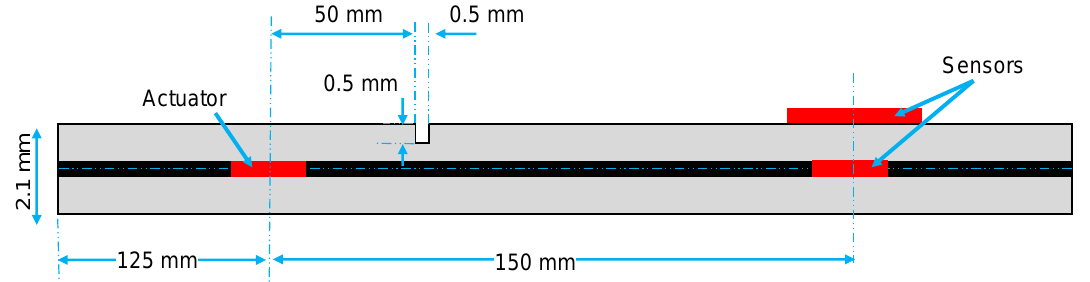
Figure 16. Schematic of a laminate structure with two d35 PZT transducers (3 mm × 0.1 mm) embedded in the bondline and a d31 PZT sensor (6 mm × 0.25 mm) mounted on the surface. A notch (0.5 mm × 0.5 mm) is introduced in the top aluminum layer.